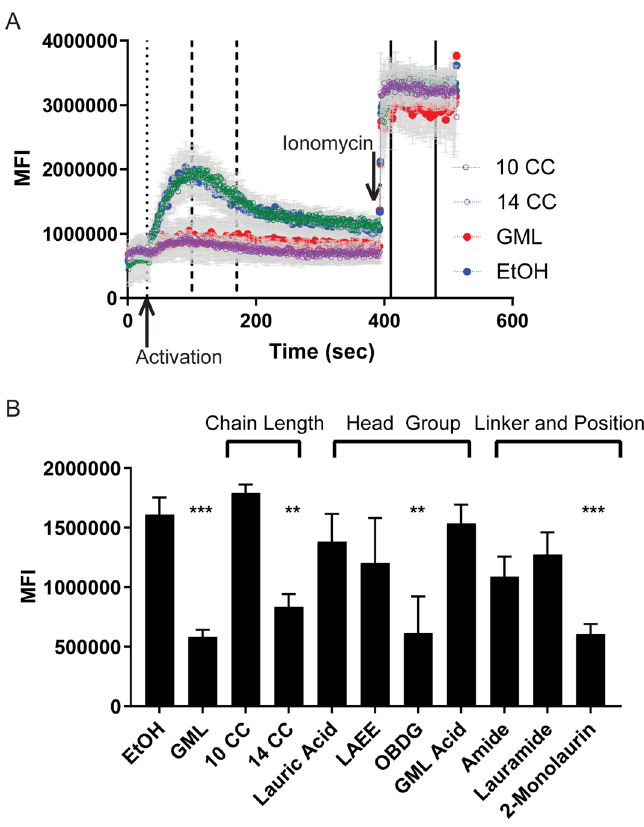
Figure 5. Chain length, head group polarity, and position impact the ability of GML to inhibit calcium signaling. Human APBTS were incubated with Fluo-4 AM cell permeable calcium dye and treated with designated compound. ( A ) Calcium flux was detected in real time using an Accuri C6 Flow cytometer. Baseline readings were taken for 30 s, cells were stimulated for 6 min, and finally were treated with Ionomycin to control for calcium dye levels. ( B ) Peak activation was averaged across 70 s (100–170 s post-stimulation) for each experiment. At least 3 independent experimental samples were compared to averaged control groups using a One-Way ANOVA with Dunnett’s multiple comparison’s test. (* p < 0.05, ** p < 0.01, *** p <